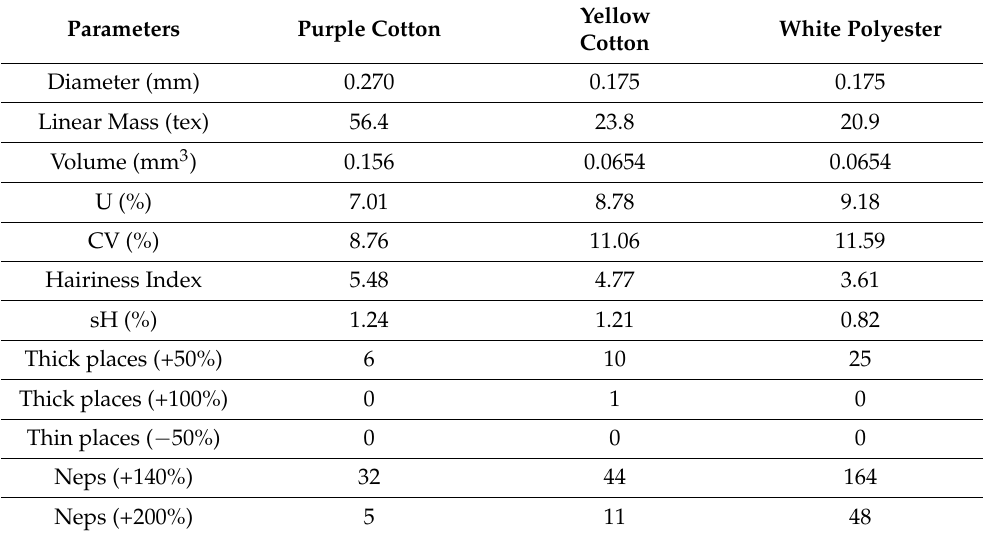
Table 4. USTER Tester 3 equipment